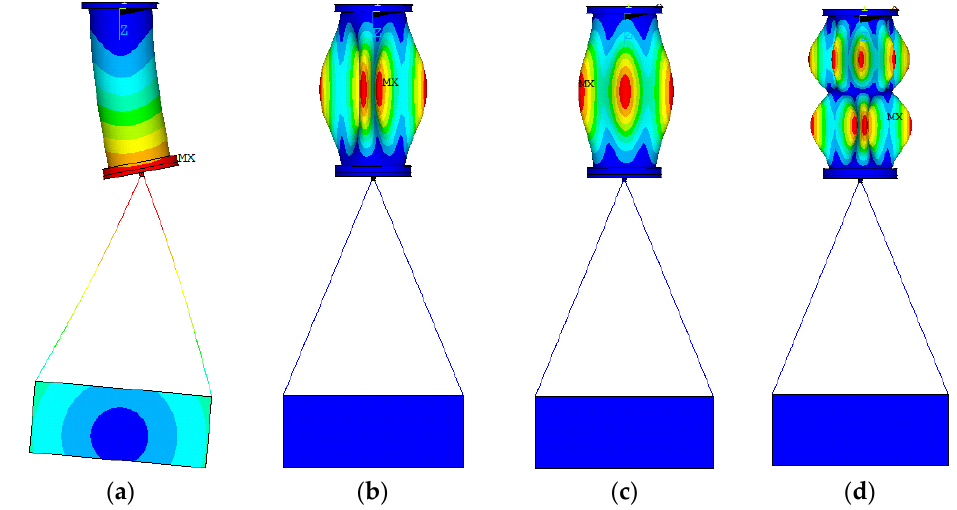
Figure 6. Fundamental vibration mode shapes: ( a ) mode (1;1); ( b ) mode (1;4); ( c ) mode (1;3); ( d ) mode (2;5).